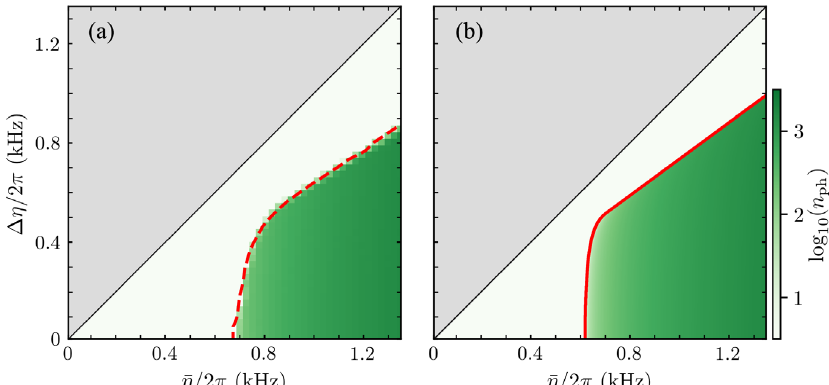
FIG. 5. Theoretical phase diagrams from numerical mean-field simulations (a) and analytic steady-state calculations (b). For both ; κ Þ ¼ 2 π · ð 44 kHz ; − 4 . 0 MHz ; 1 . 25 MHz Þ and N ¼ 1 . 28 × 10 5 atoms, to match the experimental methods, we consider ð ω 0 ; Δ c parameters. For the numerics, we carry out 427 simulations at 61 different coupling ratios Δ η = ¯ η and use S-shaped coupling ramps with 10 ms, as in the experiment. The boundary of the superradiant phase is marked in red. t ramp ¼